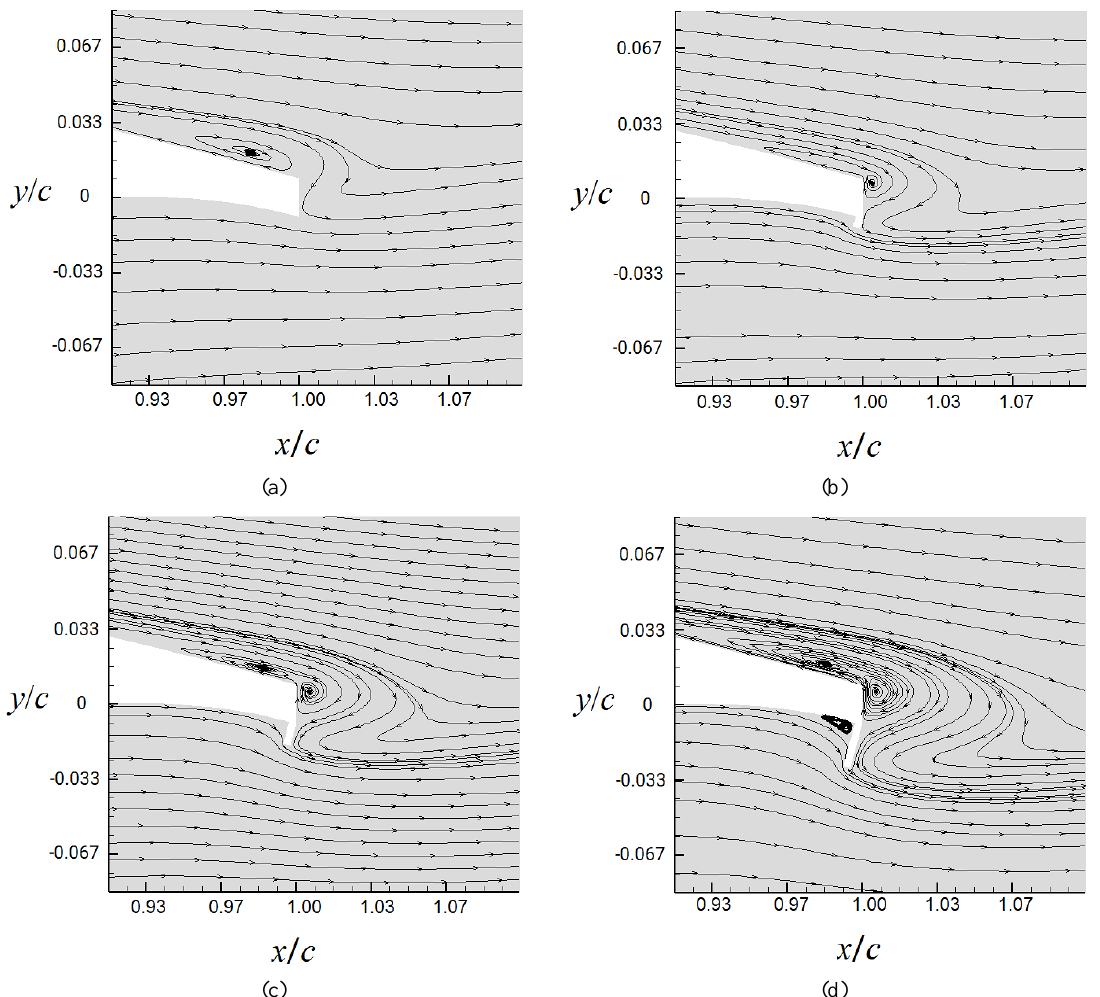
Figure 13. Flow structure at the middle plane for the airfoil equipped with (a) VGs and for the airfoil equipped with VGs in the presence of Gurney flap at heights of (b) H / c =0.5%, (c) 1% and (d)